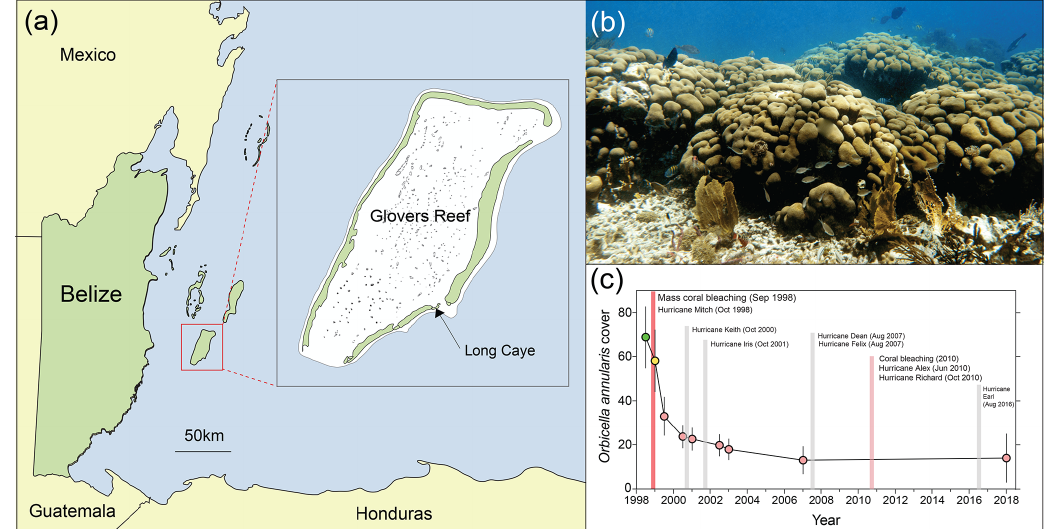
Figure 1. (a) Map of Belize and the study site (inset) at Long Caye, Glovers Reef. (b) Living Orbicella annularis colonies forming a structurally complex framework on a Caribbean reef. (c) Time series of O. annularis cover at Glovers Reef and major disturbance events between 1998 and 2018.